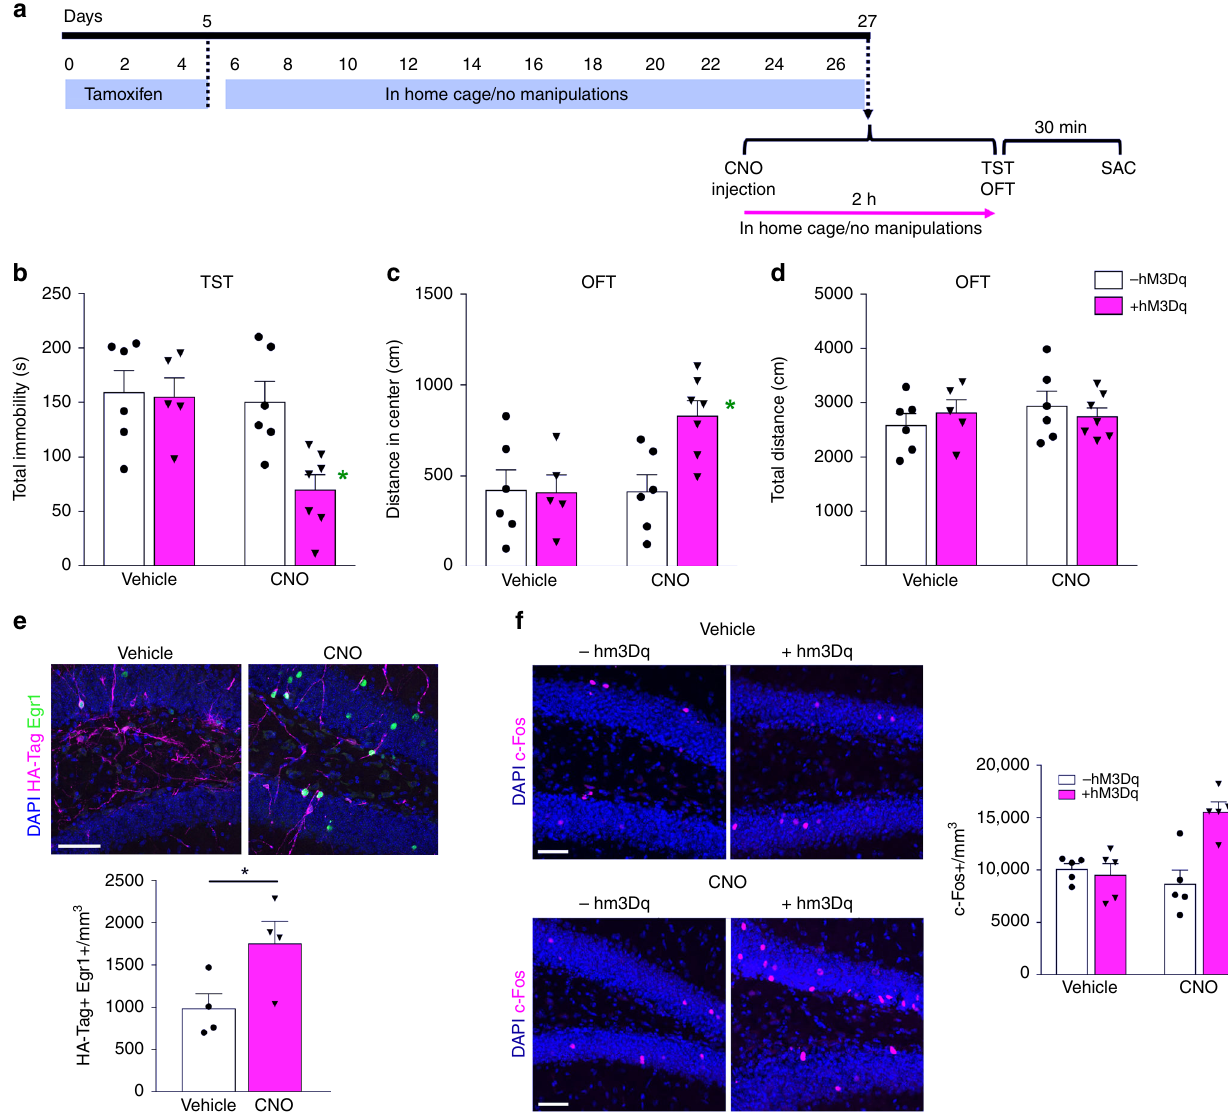
Fig. 4 Acute activation of newborn dentate gyrus neurons results in antidepressive effects. a Timeline representing experimental design for determining whether enhancing the activity of newborn neurons induces an antidepressant effect in Ascl1-CreER TM ;R26 LSL − hM3Dq mice. b Total time spent immobile in tail suspension test, a measure of depression-like behavior (hM3Dq F 1,20 = 5.86, * P = 0.025; CNO F 1,20 = 7.16, * P = 0.015; Interaction F 1,20 = 4.72, * P = 0.042; Tukey posthoc test + hM3Dq + CNO versus other groups * P < 0.05). c Center exploration distance in open- fi eld test, a measure of anxiety-like behavior (hM3Dq F 1,20 = 4.42, * P = 0.048; CNO F 1,20 = 4.65, * P = 0.044; Interaction F 1,20 = 4.98, * P = 0.037; Tukey posthoc test + hM3Dq + CNO versus other groups * P < 0.05). d Total distance in open- fi eld test, measure of locomotor activity (hM3Dq F 1,20 = 0.005, P = 0.945; CNO F 1,20 = 0.418, P = 0.525; Interaction F 1,20 = 0.927, P = 0.347). e Representative images and quanti fi cation of HA-Tag + Egr1 + double-positive cells in the dentate gyrus ( t 6 = 2.459, * P = 0.049). f Representative images and quanti fi cation of c-Fos expression in the dentate gyrus (hM3Dq F 1,16 = 10.11, ** P = 0.006; CNO F 1,16 = 5.31, * P = 0.035; Interaction F 1,16 = 13.79, ** P = 0.002; Tukey posthoc test + hM3Dq + CNO versus other groups ** P < 0.01). Data are presented as means ± s.e.m. and analyzed by two-way ANOVA ( b , c , d , and f ) or two-tailed Student ’ s t -test ( e ). Scale bar 50 μ expression of hM4Di and hM3Dq was performed at 8 – 10-weeks of age. Tamoxifen at 2h intervals and were sacri fi ced 24 h after the last injection. For conditional administration led to conditional expression of HA-tagged hM4Di and hM3Dq, expression of hM4Di and hM3Dq tamoxifen (Sigma Aldrich) was dissolved in and also mCitrine yellow fl uorescent protein (YFP) in Ascl1 -expressing cells, which was used as the fl uorophore for electrophysiological examination. Cre and/or DREADD-negative littermates from heterozygote breeding were used as controls. At least three separate cohorts of mice were run for all experiments. Drug administration . Fluoxetine (Sigma Aldrich, St. Louis, MO, USA) was dis- solved in saline and administered at a dose of 10 mgkg − 1 via intraperitoneal (i.p.) injection daily for 14 or 21 consecutive days. Control animals received daily i.p. injections of saline for 14 or 21 consecutive days accordingly. Bromodeoxyuridine (BrdU, Sigma Aldrich) was dissolved in Phosphate Buffer Saline (PBS) and for neuronal labeling mice received four consecutive i.p. injections of 50 mg kg − 1 BrdU